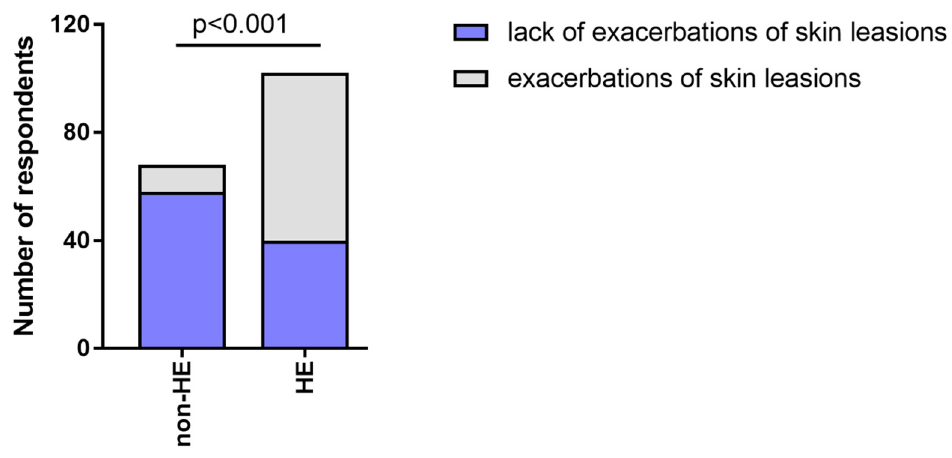
Figure 11. The frequency of exacerbations of skin lesions during the pandemic in both groups (HE-study group and non-HE).